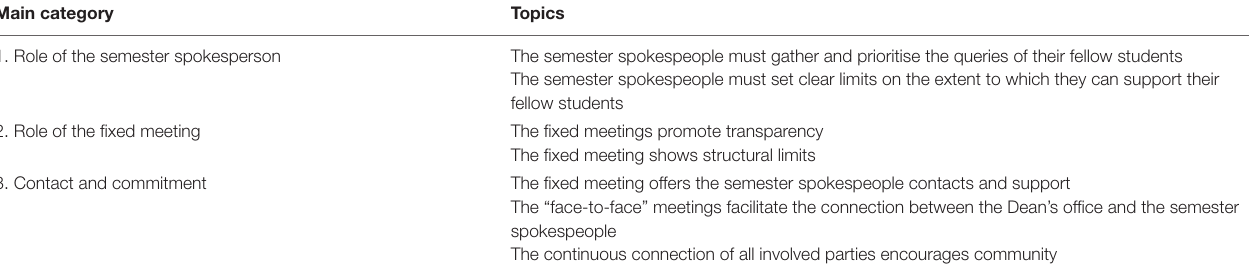
TABLE 2 | Categories and